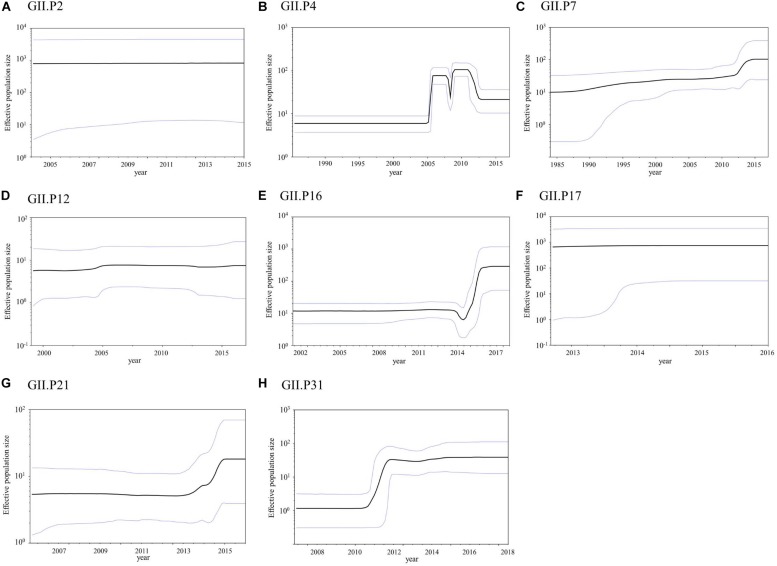
Bayesian skyline plot for the NoV GII strains. Plots for GII.P2 (A), GII.P4 (B), GII.P7 (C), GII.P12 (D), GII.P16 (E), GII.P17 (F), GII.P21 (G), and GII.P31 (H) are shown. The y-axis represents the effective population size on a logarithmic scale, while the x-axis denotes the time in years. The solid black line indicates the mean posterior value and intervals with 95% HPD are represented by blue lines.